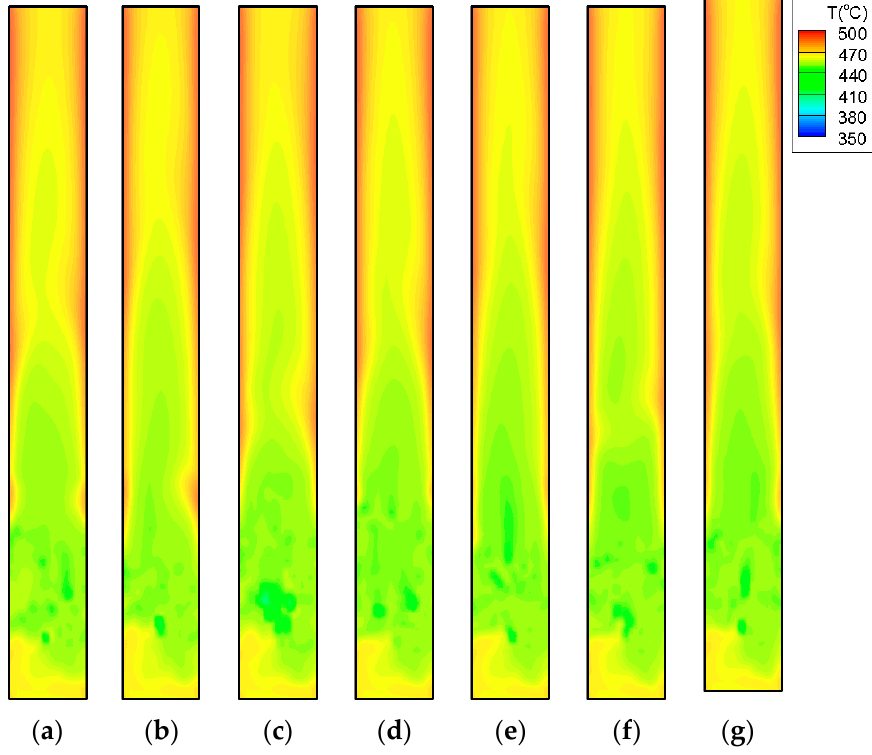
Figure 5. Temperature distributions. ( a ) 9 s, ( b ) 9.1 s, ( c ) 9.2 s, ( d ) 9.3 s, ( e ) 9.4 s, ( f ) 9.5 s, and ( g ) 9.6 s.